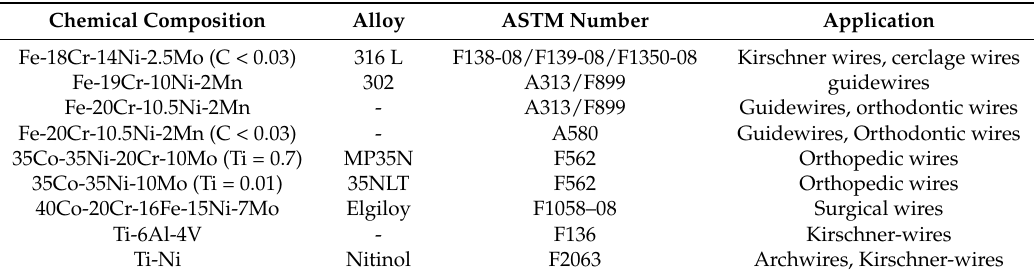
Table 2. Common permanent biomaterials used for bone wires, data from